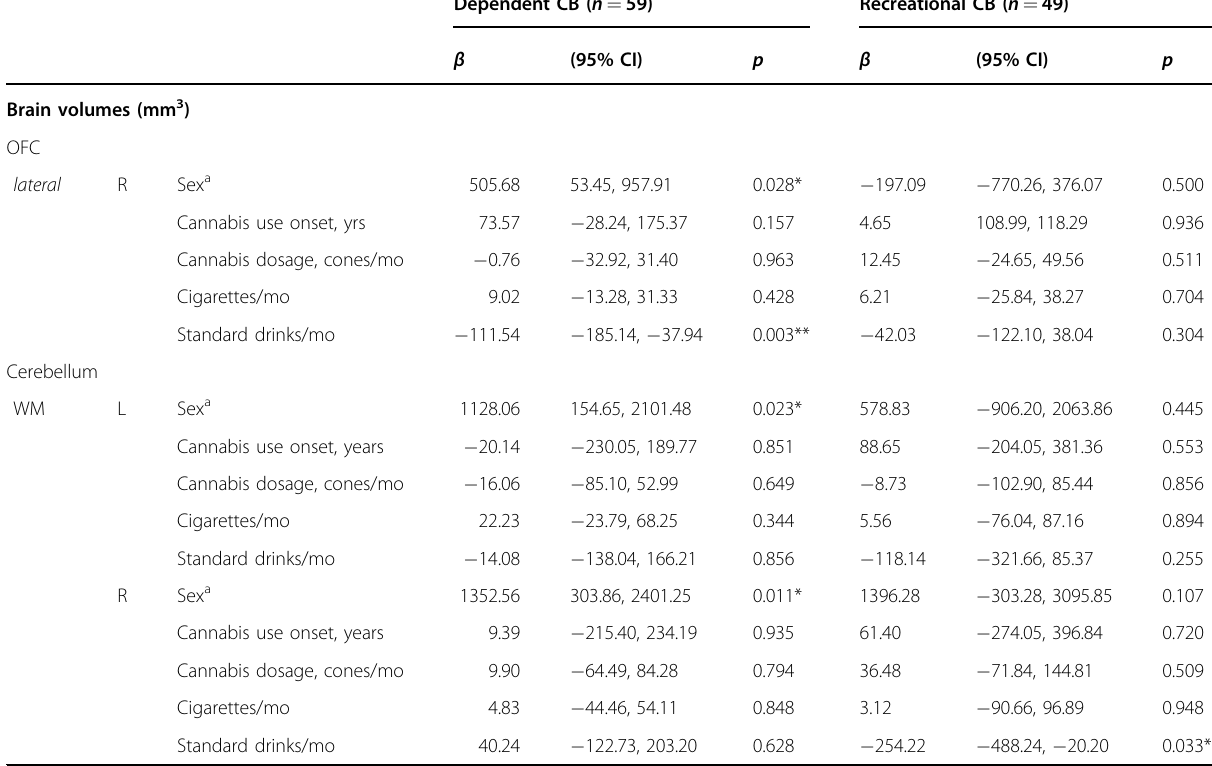
Table 3 Associations between regional brain volumes and substance use levels separately in cannabis users with and without dependence (three-site